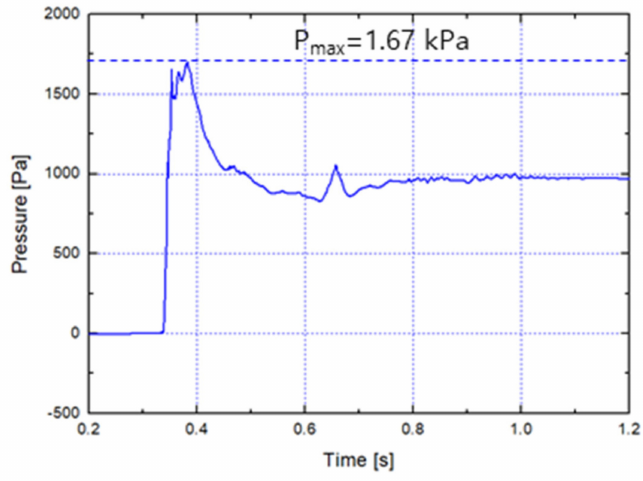
Figure 3. Comparison of pressure history of present study.